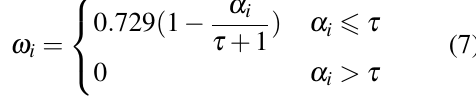
Table 1. Statistic results of α for the six test functions. f